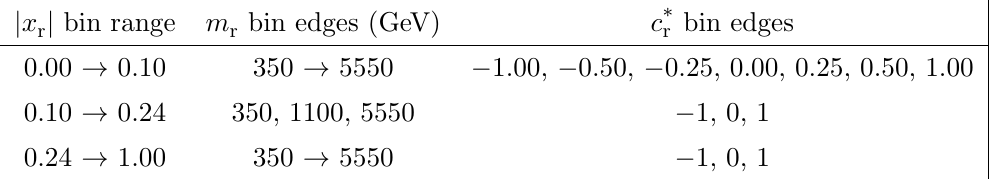
Table 3 . Template binning in the type-1 m +jets signal regions (each template has 12 total bins).